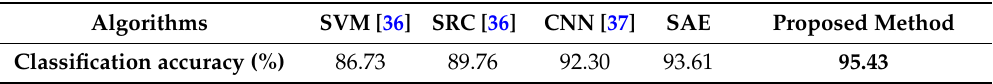
Table 5. The classification accuracy of different algorithms.